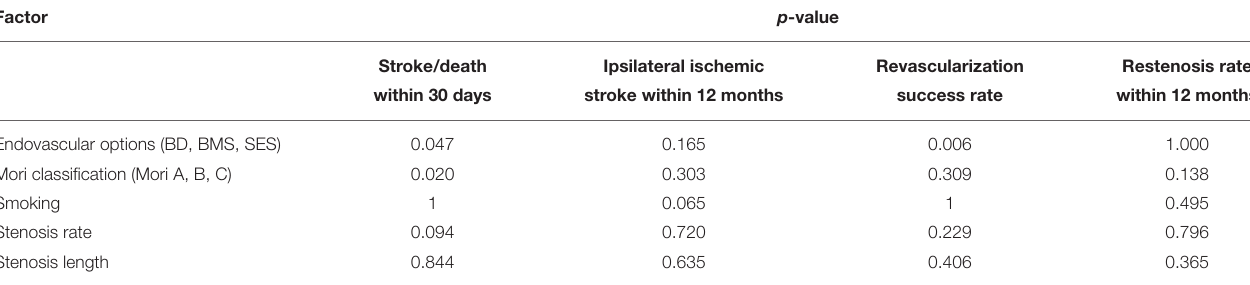
TABLE 3 | Factors associated with primary and secondary